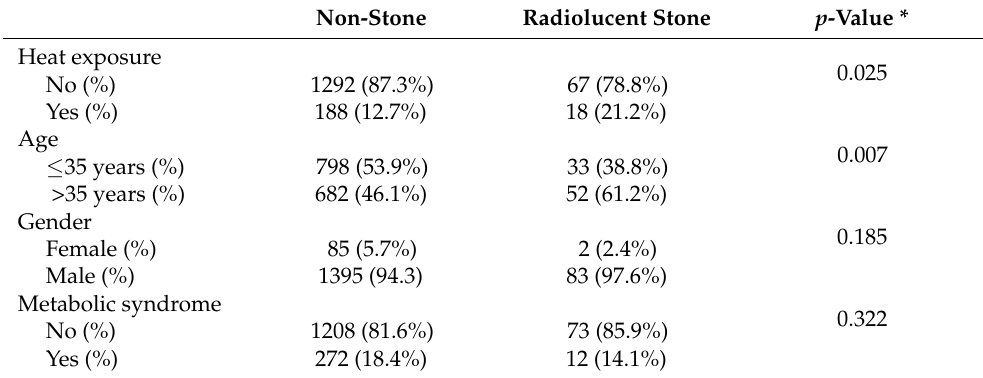
Table 2. Chi-square test of radiolucent stone and non-stone groups by gender, heat exposure, and age. Non-Stone